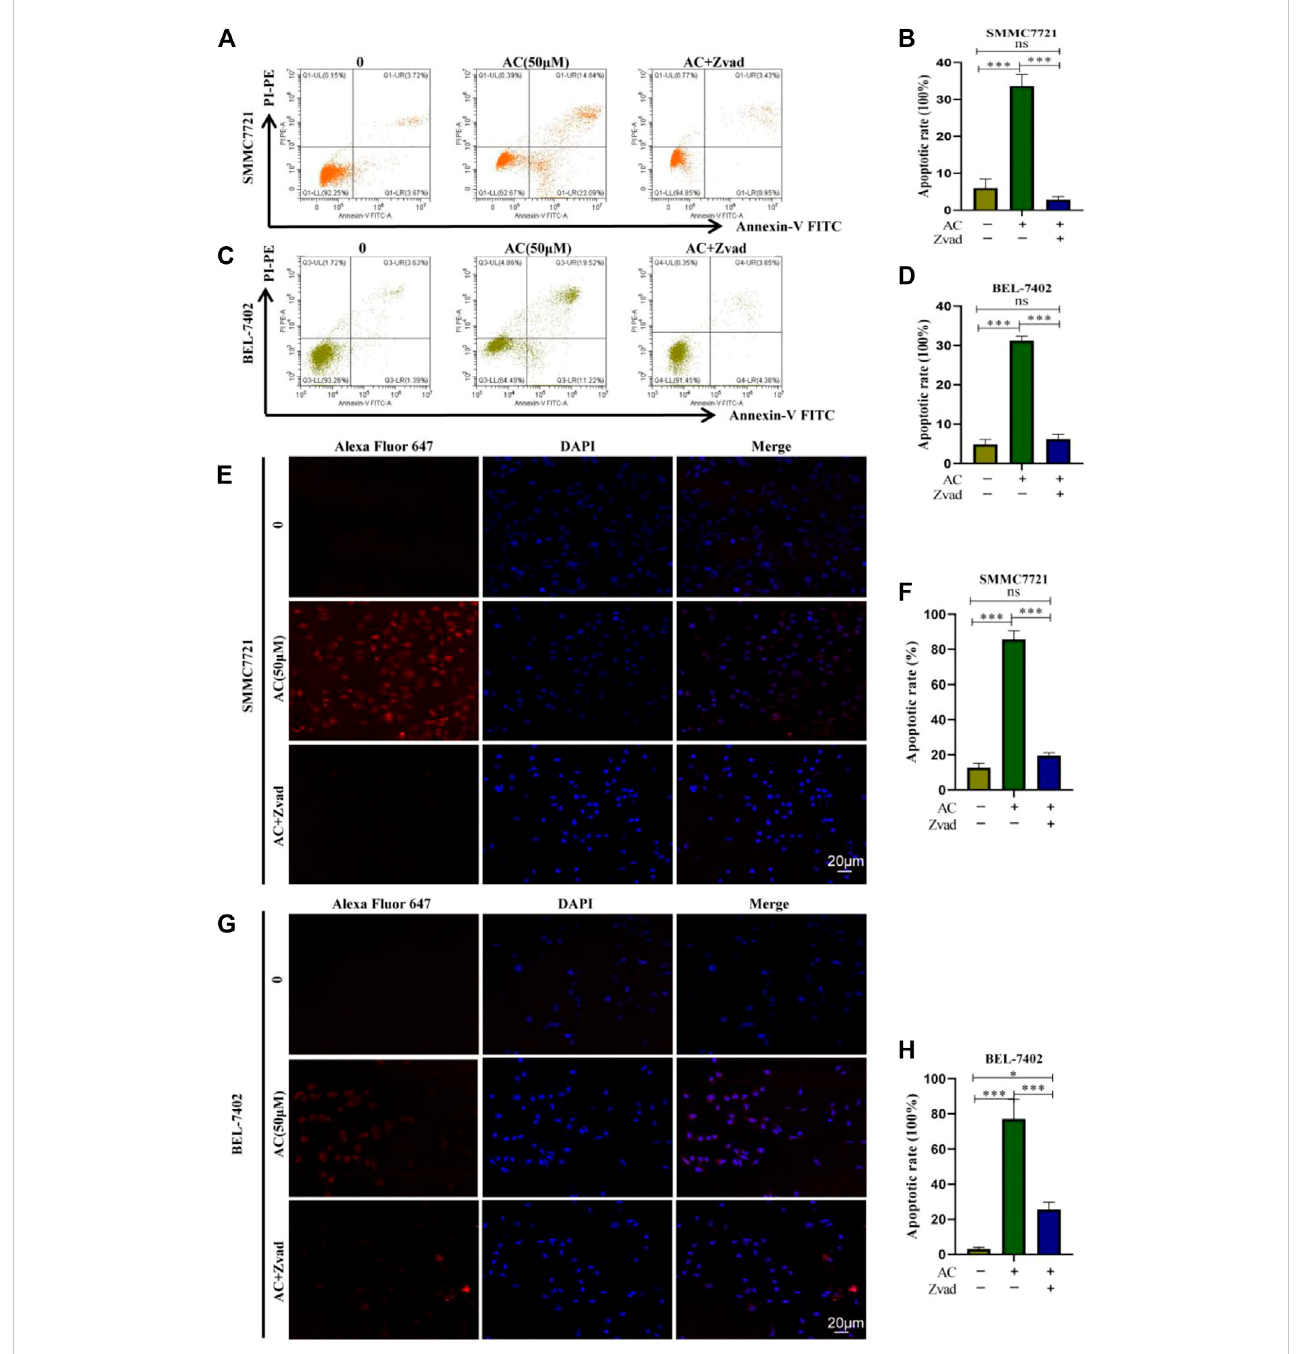
Reversal effect of Zvad on AC-induced apoptosis of hepatocytes. (A , B) Reversal effect of Zvad on AC-induced apoptosis of SMMC7721. (C , D) Reversal effectofZvadonAC-induced apoptosisofBEL-7402. (E , F) ReversaleffectofZvadonAC-inducedapoptosisofTUNELinSMMC7721. (G , H) Reversaleffectof ZvadonAC-inducedapoptosisofTUNELinBEL-7402.Theimageofconfocal,andapoptoticcellswasstainedbyALEX647(red),andthenucleiweredyedblue by DAPI. * p < 0.05; ** p < 0.01; *** p < 0.001 (vs . 0 group).